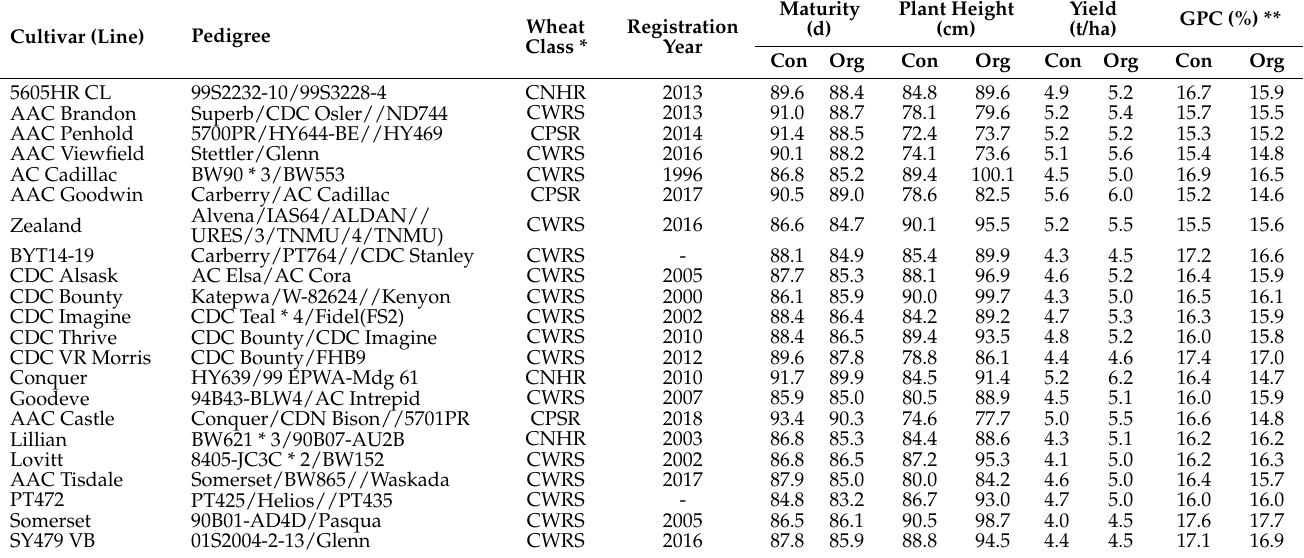
Table 2. The pedigree information and summary of best linear unbiased estimators for the 22 selected cultivars and lines based on 5 conventionally (Con) and 4 organically (Org) managed environments.